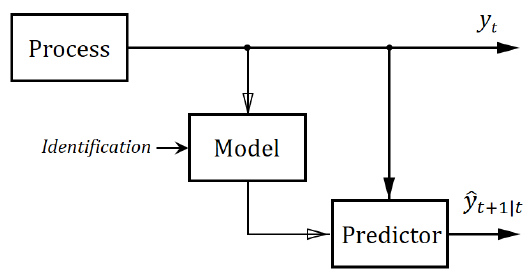
Figure 3. Prediction of the stochastic process.